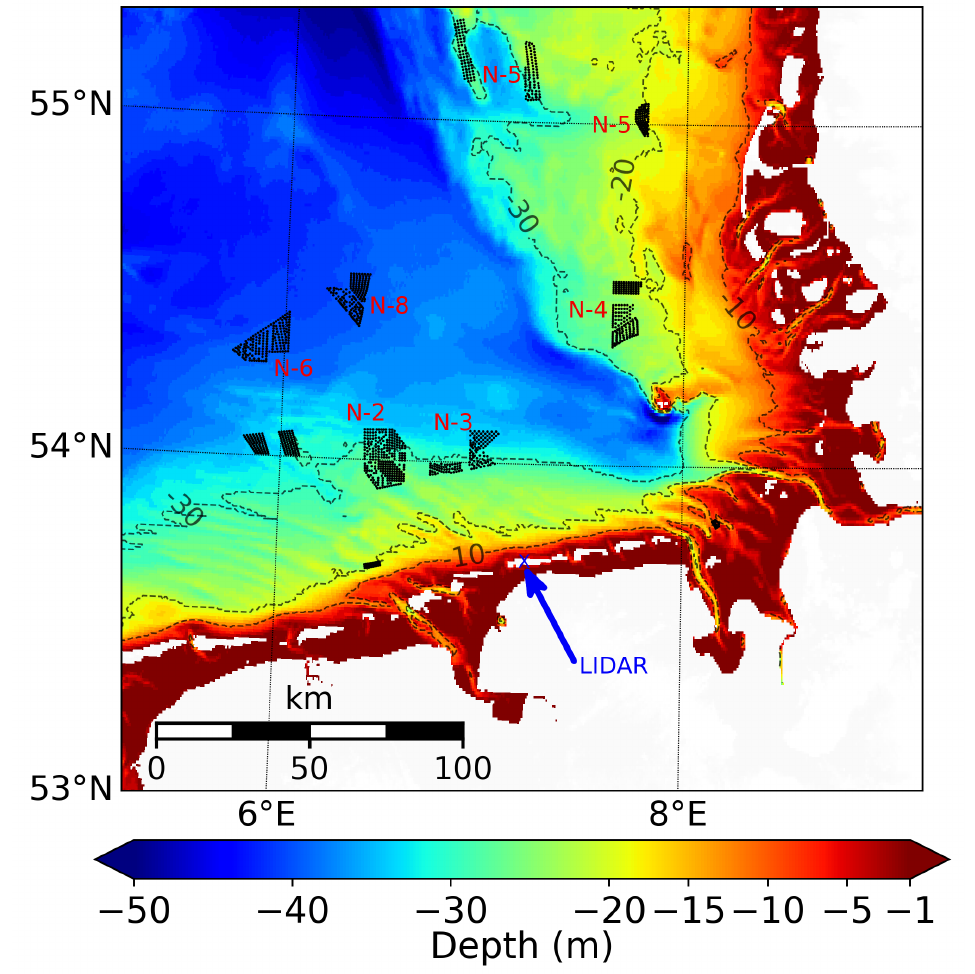
Figure 1. Water depths in the German Bight [24]. The black dots correspond to offshore wind turbines installed by June 2020. The blue arrow indicates the location of the LIDAR (see Section